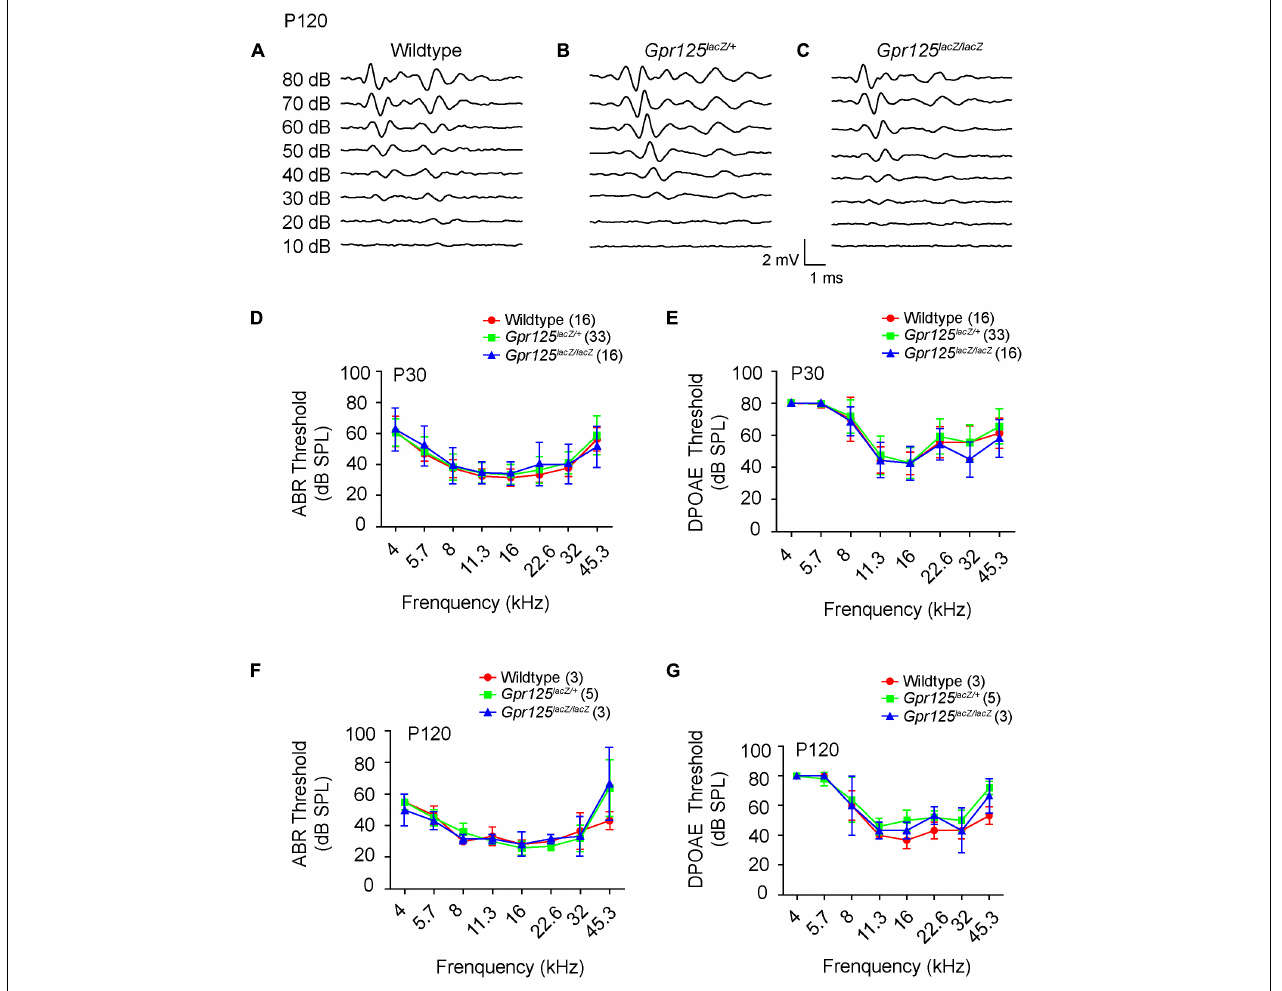
FIGURE 7 | Gpr125 lacZ / lacZ mice exhibit normal auditory physiology. (A–C) Representative ABR waveforms of P120 wild-type, Gpr125 lacZ / + , and Gpr125 lacZ / lacZ mice. (D–G) Comparable ABR and DPOAE thresholds of P30 and P120 wild-type, Gpr125 lacZ / + , and Gpr125 lacZ / lacZ littermates. No significant differences